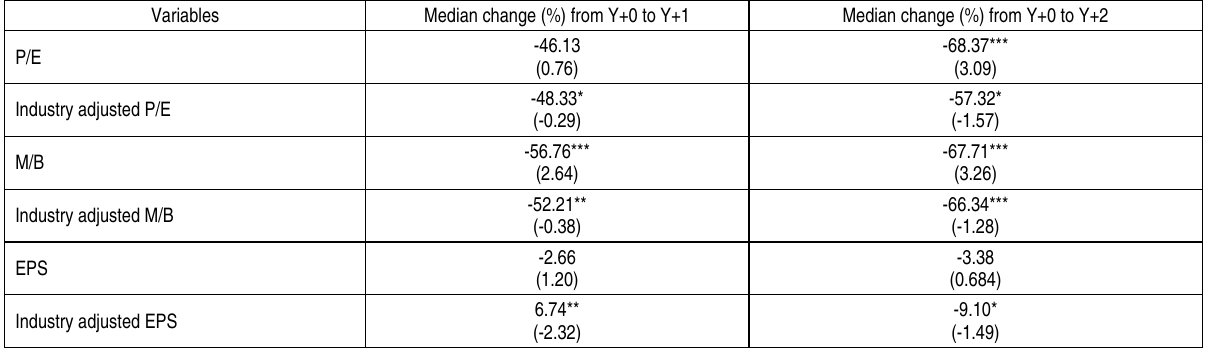
Table 4. Median change in market expectations and earnings potential of Indian firms around their IPO